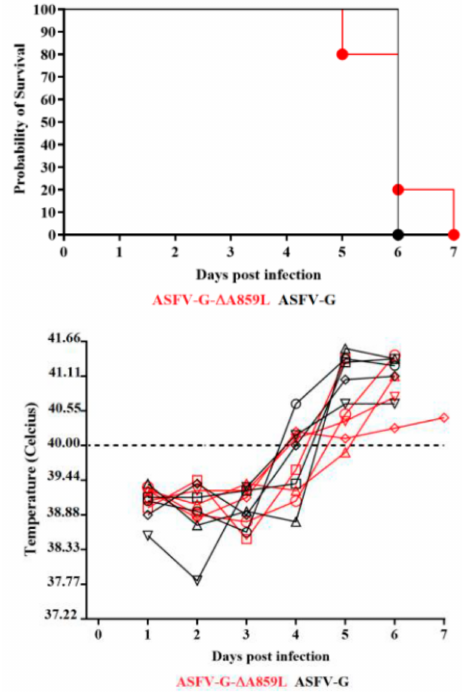
Figure 4. Evolution of mortality of animals ( top panel ) and body temperature, each symbol repre- senting a different animal in the indicated group of animals ( bottom panel ) (5 animals/group) IM infected with 10 2 HAD 50 of either ASFV-G- ∆ A859L or parental ASFV-G. No significant differences were found in the survival course between groups of pigs using the Log-rank test (Mantel–Cox test). No statistical differences were found in body temperatures between pigs in both groups when evaluated by the Holm–Sidak method ( α = 0.05). All calculations were conducted using the software GraphPad Prism version